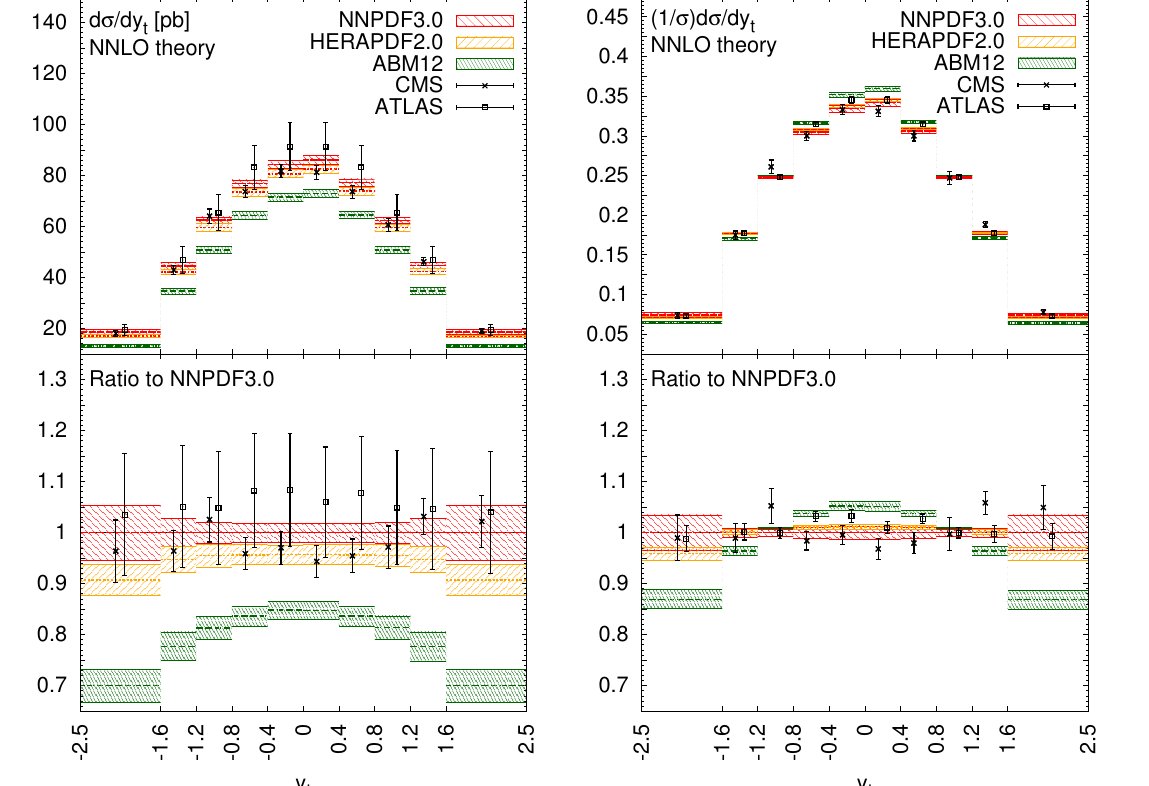
Figure 8 . Same as (cid:12)gure 7 now for NNPDF3.0, ABM12 and